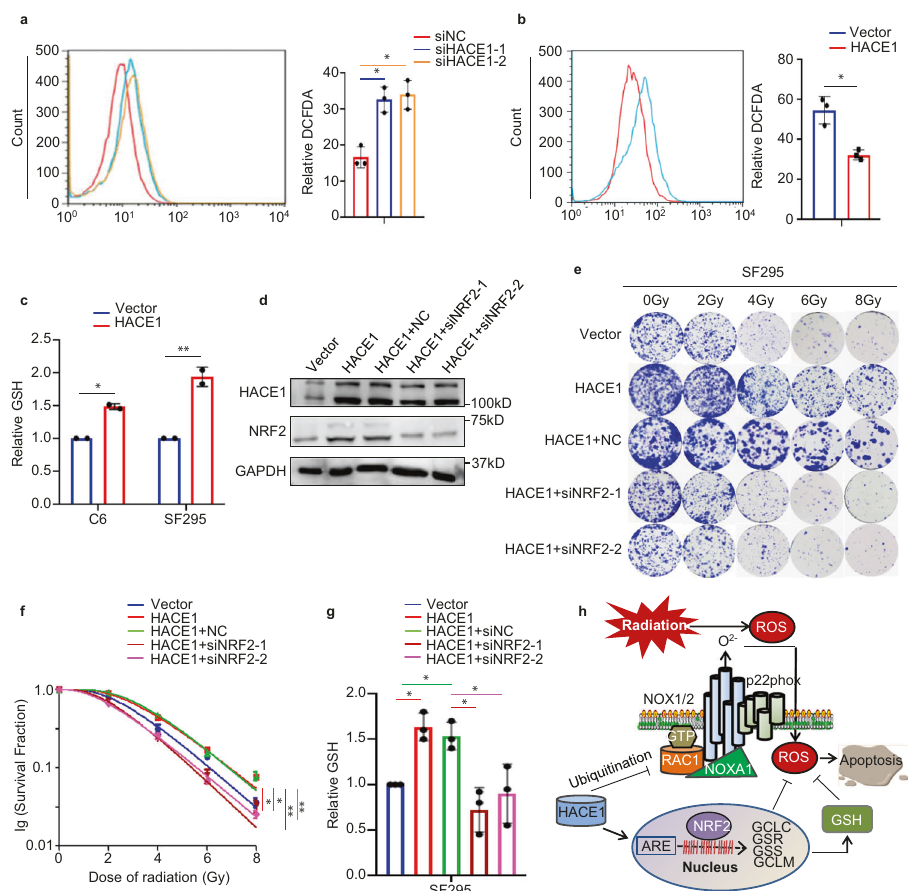
Fig. 7 HACE1-mediated NRF2 activation reduces radiosensitivity of glioma cells by elevating cellular GSH content and reducing ROS content. a The effect of HACE1 knockdown in SF295 cells on cellular ROS levels was measured by CM-H2-DCFDA. b HACE1 overexpression-SF295 cells and control cells were treated with a 4 Gy X-ray. ROS production was then analyzed by DCF staining assay 24 h post-radiation. Left panel: the fl uorescence intensity of ROS-positive cells. Right panel: the bar graph showing mean ± SD. c Measurement of cellular GSH content in HACE1 overexpression-C6 or SF295 cells and control cells. d Western blot analysis of HACE1, NRF2, and GAPDH (loading control) in SF295 cells with the indicated treatments. e , f The effect of NRF2 knockdown on the response of SF295 cells expressing HACE1 to radiation. g The effect of NRF2 knockdown in HACE1 overexpression-SF295 cells on cellular GSH levels. h A schematic model of HACE1 reducing radiosensitivity of glioma cells by regulating cellular ROS levels. The data were expressed as mean ± SD. * P < 0.05; ** P <